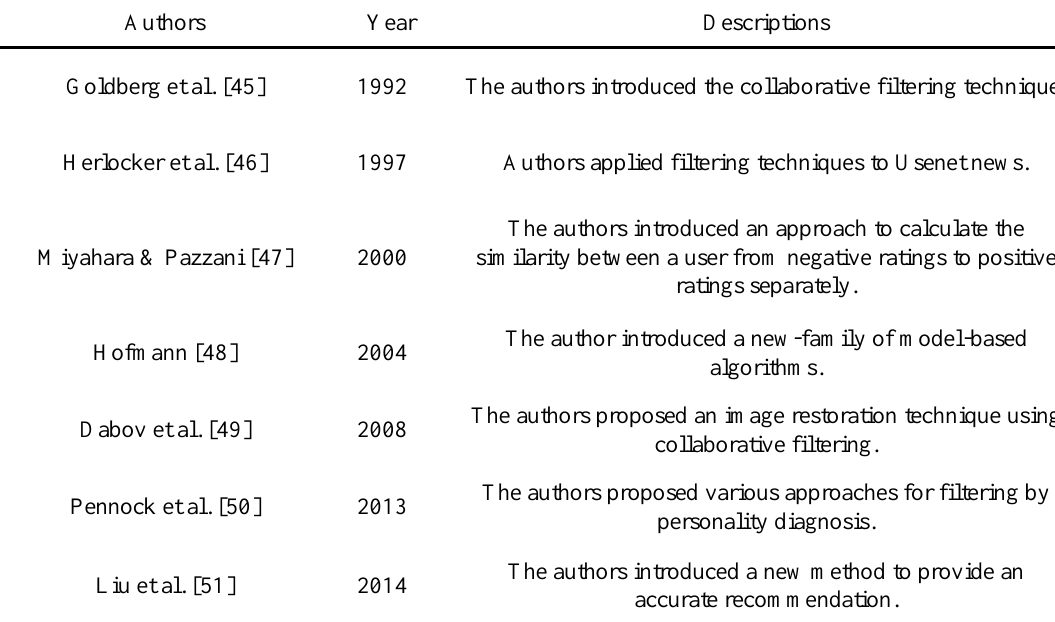
Table 2 discussed the contribution of filtering techniques for different purposes. Table 2. Literature review of filtering